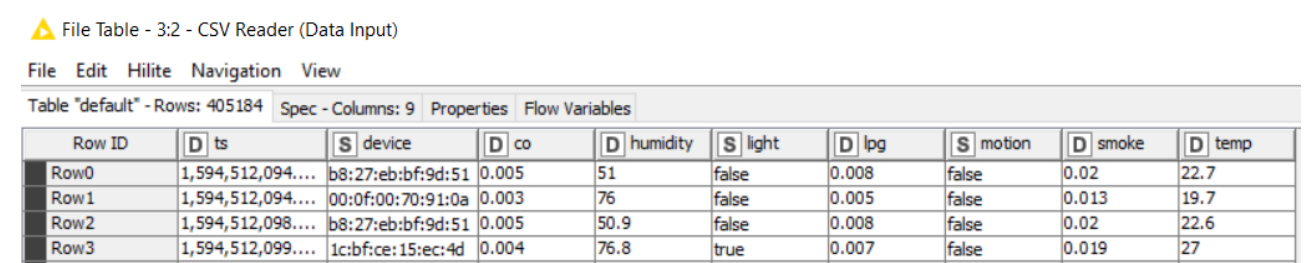
Figure A1. Screenshot of the Csv Reader table indicating the imported variables and the total number of the processed records (405,184 rows).